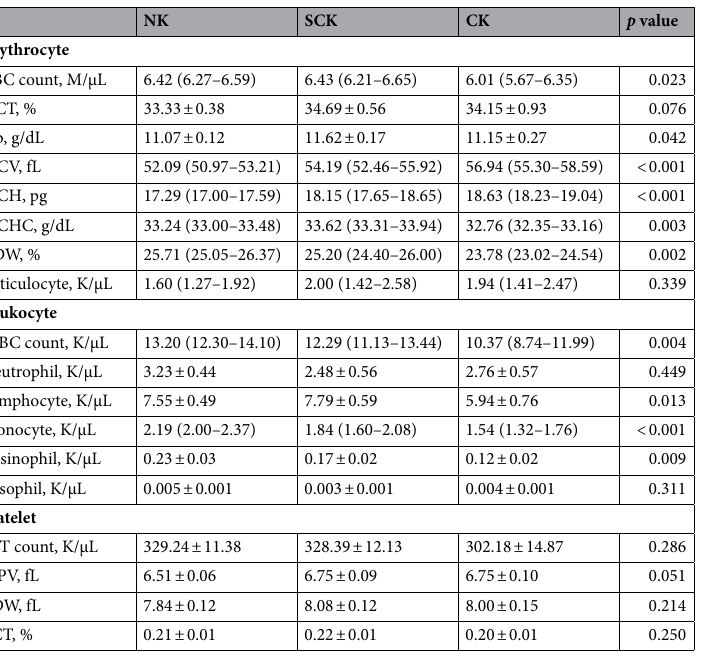
Table 2. The complete blood count (CBC) test results of each group. Data obtained using one-way ANOVA are expressed as mean (95% confidence interval), and data obtained using the Kruskal–Wallis test are expressed as mean ± standard error of the mean. RBC, red blood cell; HCT, hematocrit; Hb, hemoglobin; MCV, mean corpuscular volume; MCH, mean corpuscular hemoglobin; MCHC, mean corpuscular hemoglobin concentration; RDW, red cell distribution width; WBC, white blood cell; PLT, platelet; MPV, mean platelet volume; PDW, platelet distribution width; PCT,